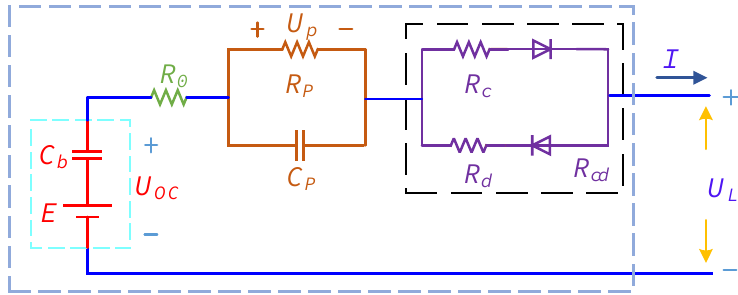
Figure 1. Internal resistance — polarization circuit model.